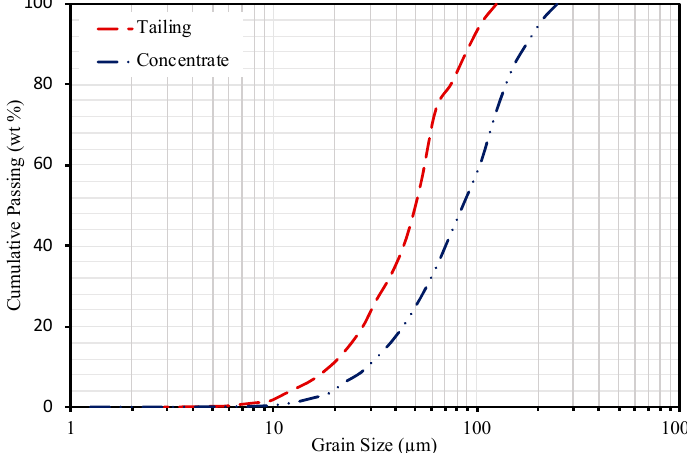
Figure 6. Mineral grain size distribution of scheelite from the sample determined by mineral liberation analysis (MLA).